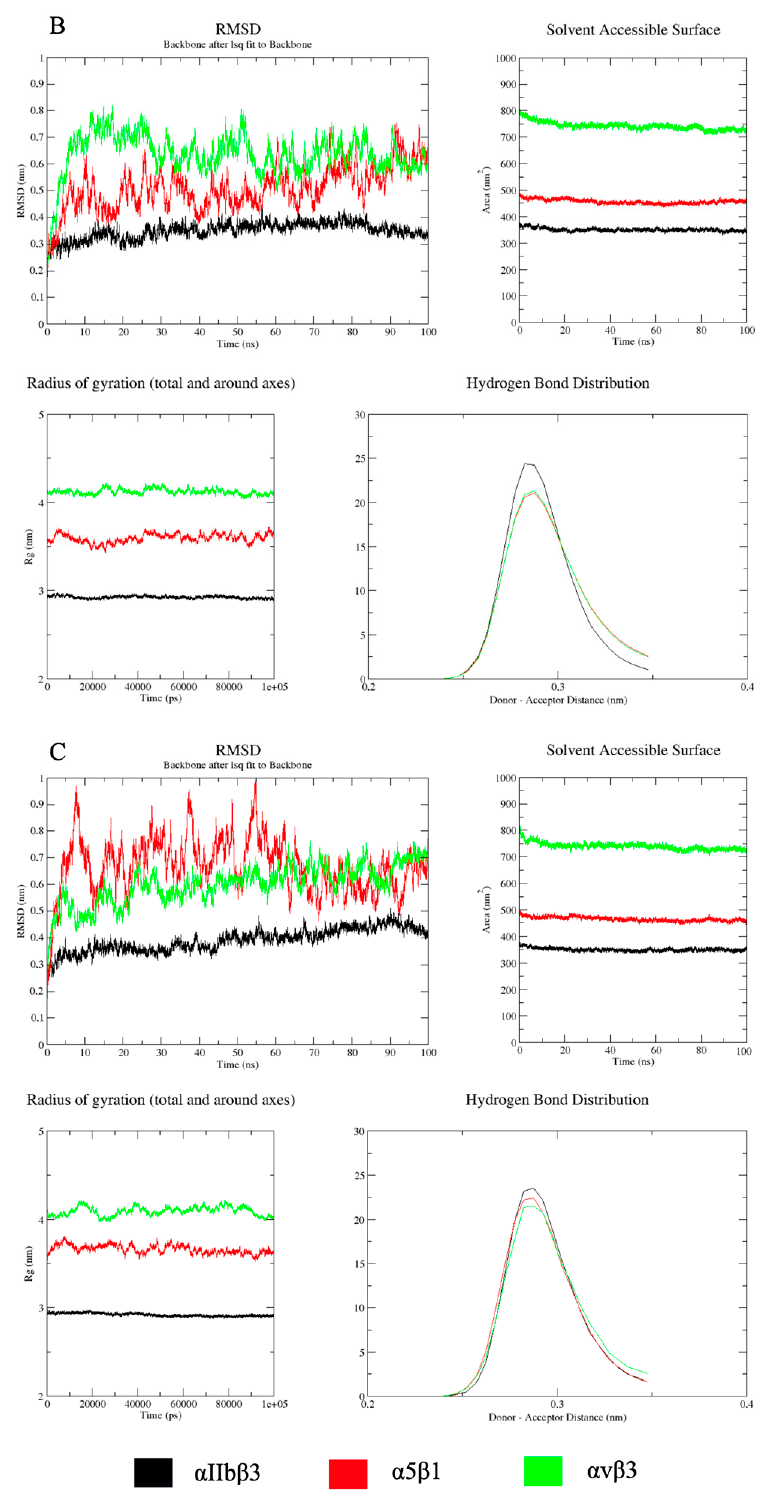
Figure 1. Pep1 ( A ) and pep3 ( B ) demonstrated the lowest RMSD, SASA, and Rg values and, therefore, the highest complex stability with integrins α IIb β 3, α 5 β 1, and α v β 3, respectively. Considering pep8 ( C ), integrins α 5 β 1 and α v β 3 demonstrated very similar RMSD values; however, SASA and Rg values showed that this peptide also demonstrated highest stability for integrins α IIb β 3, α 5 β 1, and α v β 3,